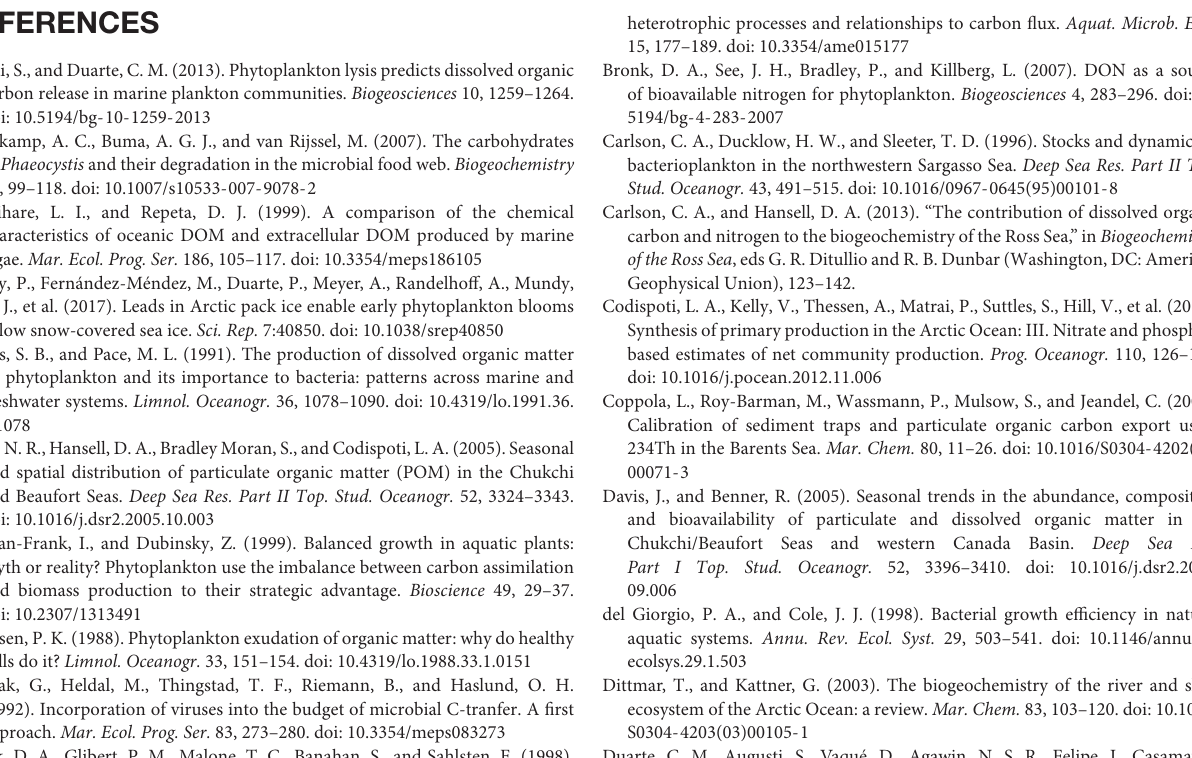
FIGURE S2 | Depth profiles of carbon to nitrogen ratios (atom : atom) of dissolved organic matter (DOM), particulate organic matter (POM), and sinking POM retrieved from sediment traps (dashed line indicates the Redfield ratio), and the abundance of bacteria and heterotrophic nanoflagellates as well as the ratio of virus to bacteria at all stations in May (upper) and August (lower) . The P-stations are emphasized with circles in May and diamonds in August, while the gray lines indicate other stations sampled during the same month ( Figure 1 ). FIGURE S3 | Median and percentiles (5 and 95%) of abundance of heterotrophic nanoflagellates (HNF), the ratio of virus to bacteria (Virus:Bac), as well as bacterial production (BP) and cell-specific bacterial production (BP/Bac), within the upper 100 m of the water column at all stations in January, March, May, August, and November. Note difference in scales. No data (n.d.). TABLE S1 | Overview over the conditions at the process station in May and August as given in Randelhoff et al. (2018): sea ice concentrations, depths of the mixed layer ( d ML ), photic zone ( Z eu ) and the upper and lower end of the nitracline ( d N ) at each station. The water layer from the surface to the lower end of d N defines here the productive layer (0–30 m in May; 0 – 40 m in August). The average concentration of nitrate and nitrite (NO x ), phosphate (PO 43 − ), silicate (Si), and chlorophyll a (Chl a ) within the productive layer are given (range of concentrations given in brackets). The phytoplankton bloom stage is classified as given in Reigstad et al. (unpublished). TABLE S2 | Correlation matric (non-parametric Spearman’s rho, ρ ) of particulate organic carbon (POC), particulate organic nitrogen (PON), dissolved organic carbon (DOC), dissolved organic nitrogen (DON), nitrate, nitrite and ammonium (DIN), and chlorophyll a (Chl a ) concentration at all depth (0 – 1000 m) at all stations in May and